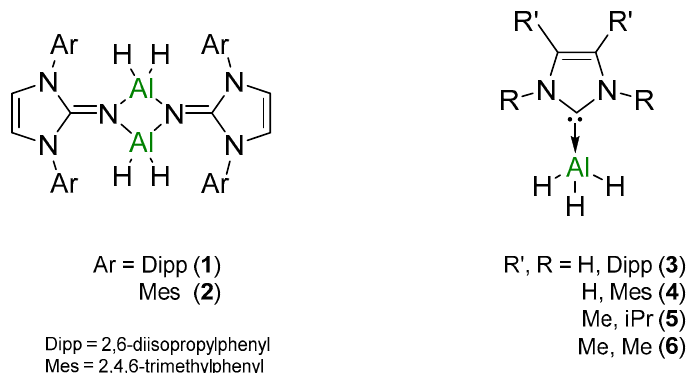
Figure 2. Series of Al(III) hydrides utilized in the dehydrocoupling of amine–boranes.